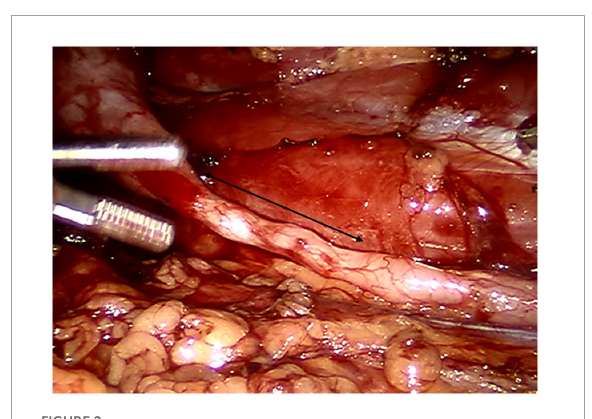
FIGURE2 Measurement of the length of ureteral stricture (as indicated by the